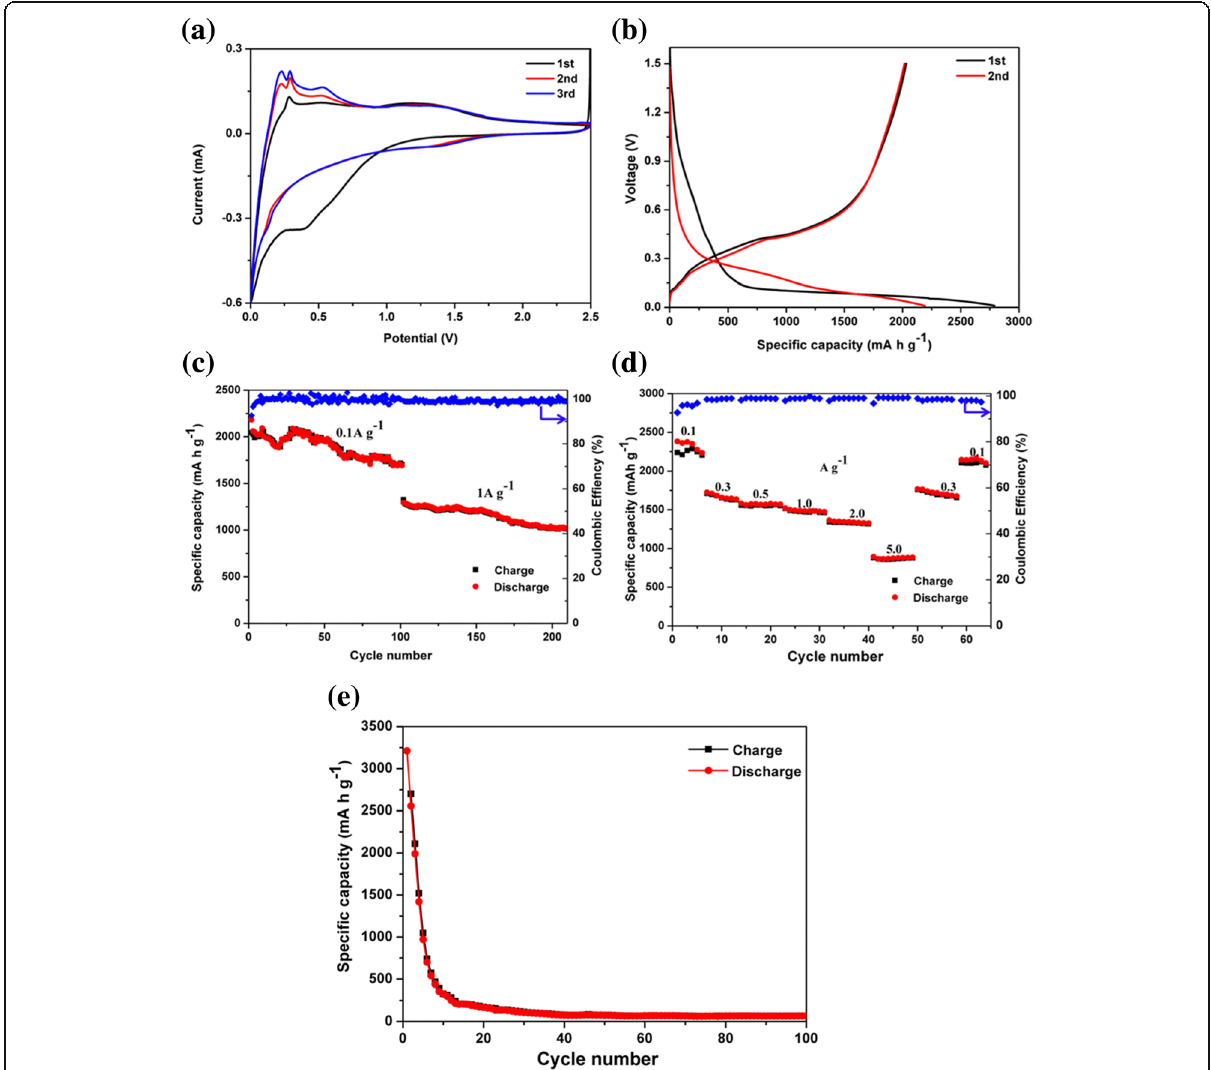
Fig. 4 a CV curves, b charge-discharge curves, c long-term cycling performance at 0.1 A g − 1 and 1 A g − 1 for 100 cycles, respectively (current densities), and d rate performance cycled at various current densities of the pSi@NC composite electrode. e Cycling performance of commercial Si@NC composite at 0.1 A g − 1 for 100